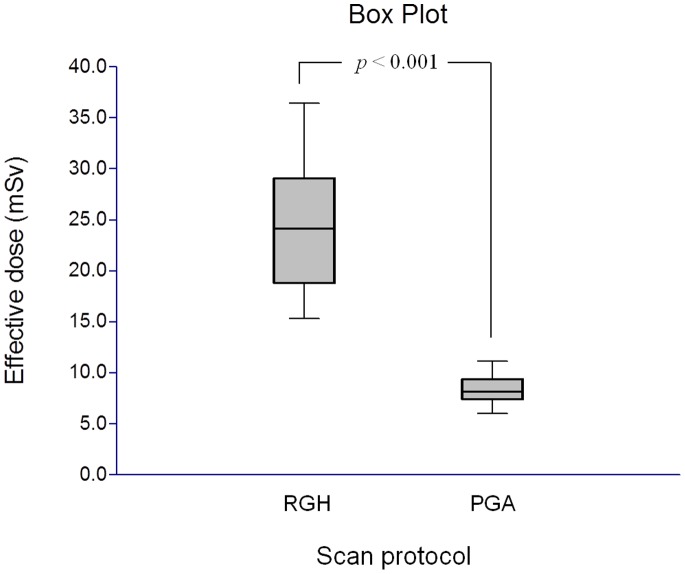
Box-and-Whisker plot showed the effective radiation doses of PGA group vs. RGH group.Box  = 1st to 3rd quartiles, mid-line  =  median and whiskers  =  minimum and maximum values.